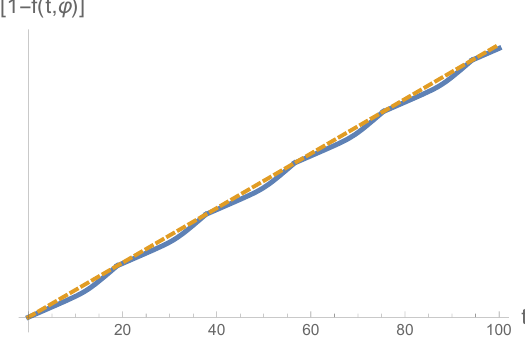
Figure 14 . The blue line is log (1 (cid:0) f ( t; ’ )) at ’ = 0 as function of time for ^ (cid:12) = 2 (cid:25); ^ ! = 1 = 3 ; ‘ = 1. The orange dashed line is (the logarithm of) e 2 (cid:25) (cid:12) t . The blue curve is a periodic modulation on this exponentially growing piece.